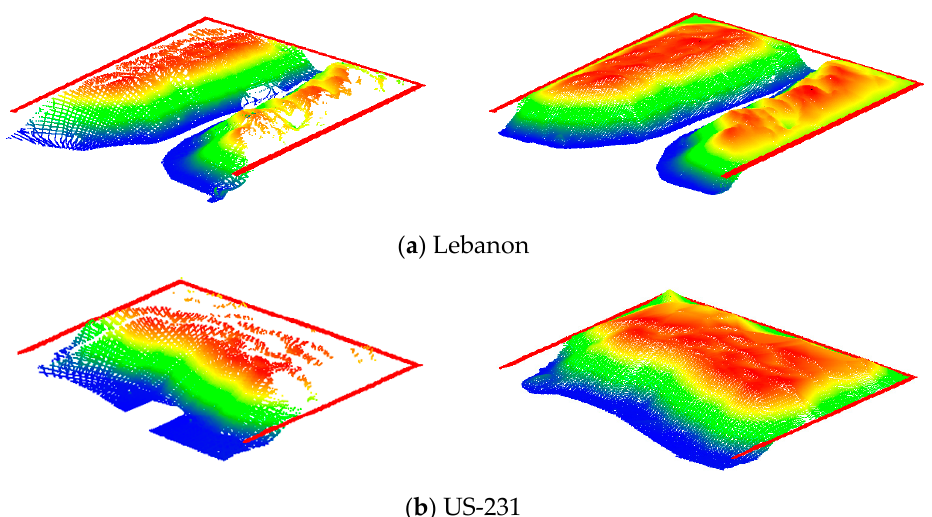
Figure 28. Stockpile surfaces from SMART before and after interpolation. Original point cloud after fine registration ( left ) and point cloud after surface interpolation ( right ): point cloud colored by height.